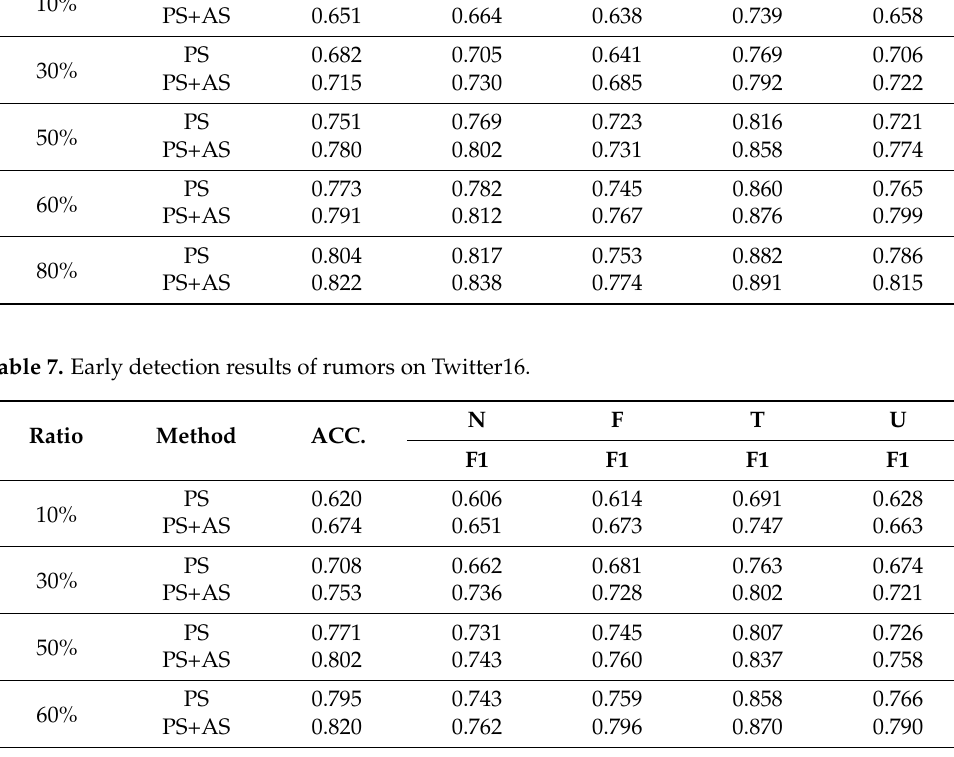
Figure 8: 192 × 4, 192 × 96 × 4, 192 × 96 × 48 × 24 × 4, 192 × 96 × 48 × 24 × 12 ×